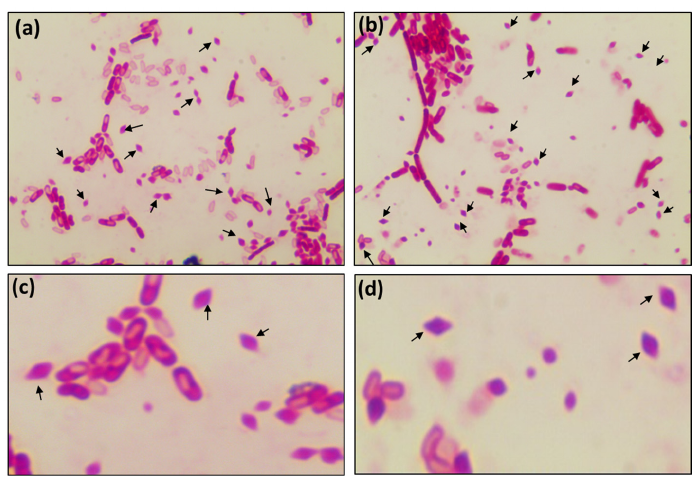
Figure 6. Crystal protein staining for the detection of Bacillus thuringiensis . ( a ) Bacillus thuringiensis KCTC3452; ( b ) Microbial isolate D-1 (100× magnification). ( c , d ) A magnified view of ( a , b ). Arrows show the presence of tetragonal (diamond-shaped) toxin crystals.